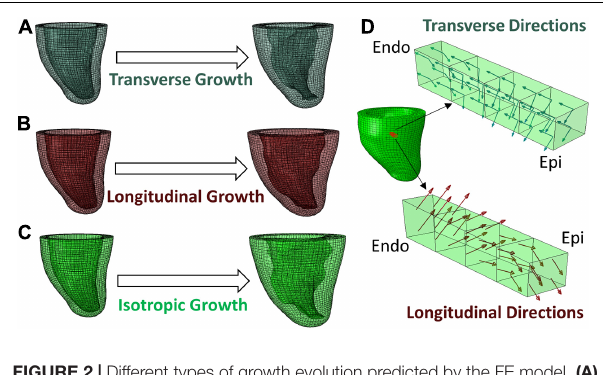
FIGURE 2 | Different types of growth evolution predicted by the FE model, (A) transverse growth, (B) longitudinal growth, (C) isotropic growth. (D) Demonstration of transverse and longitudinal growth directions in a block of myocardium from endocardium to epicardium.